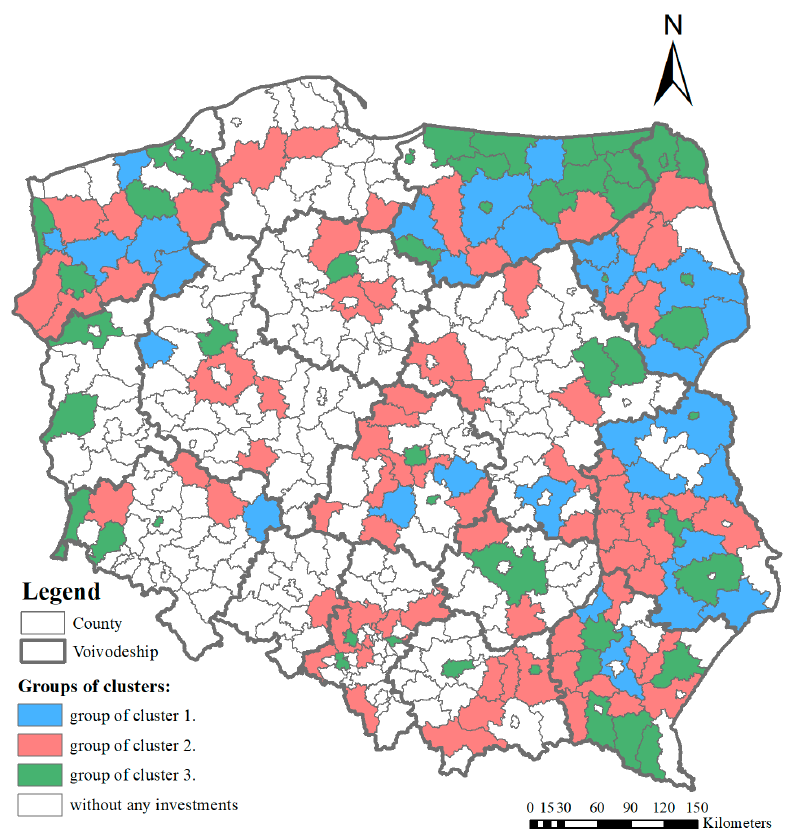
Figure 3. Spatial distribution of solar energy clusters.